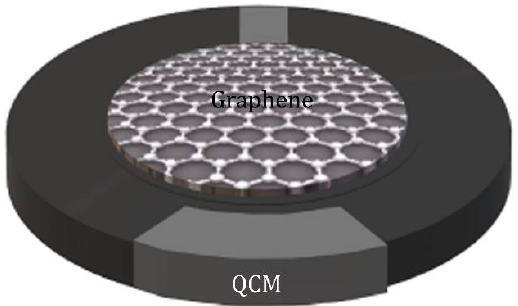
Figure 2. Schematic diagram of a graphene-based quartz crystal microbalance sensor.